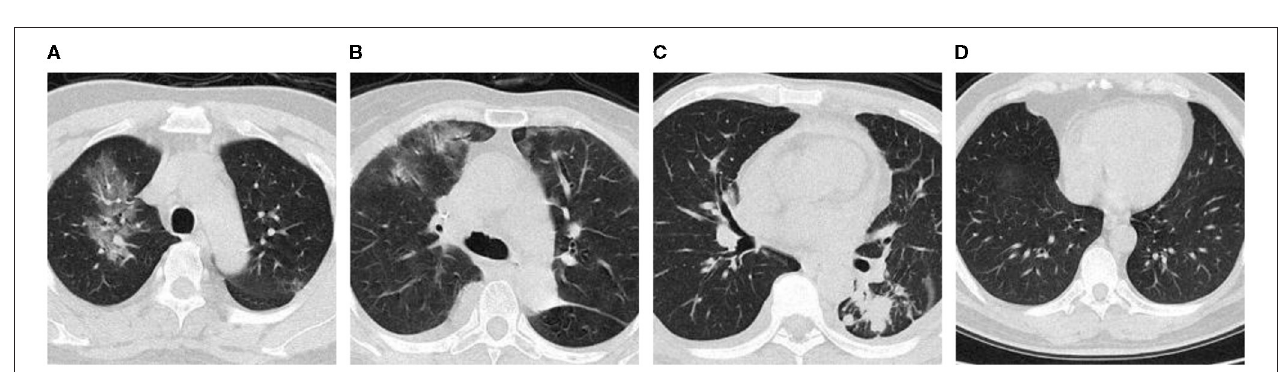
1, 2, 3, and 4). (A) k =